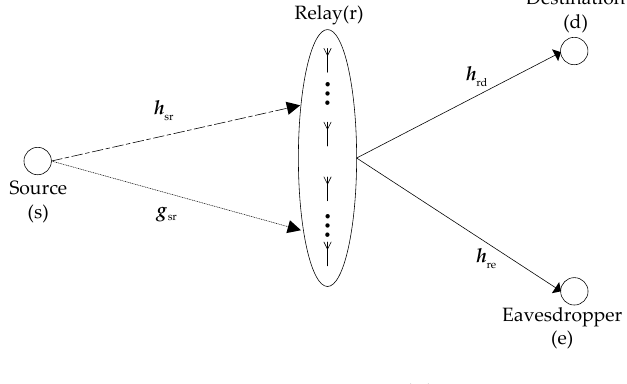
Figure 1. System Figure 1. System model.